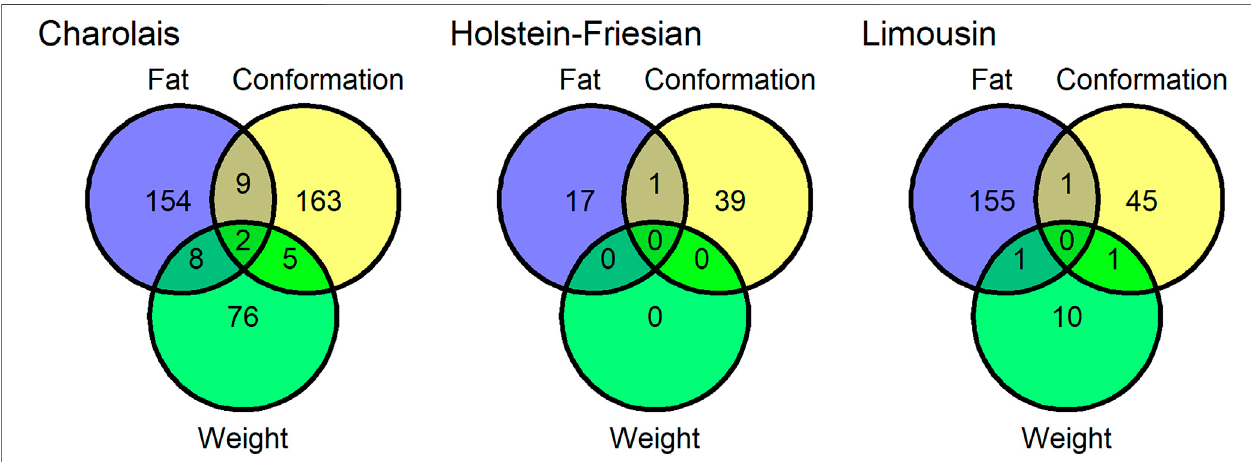
FIGURE1| Thenumberquantitativetraitloci(QTLs)associatedwithcarcassconformation,carcassfatandcarcassweightintheCharolais,Holstein-Friesians,and Limousins. Quantitative trait loci that overlapped in genomic position with another QTL associated with a different trait in the same breed were considered a single QTL shared between the two